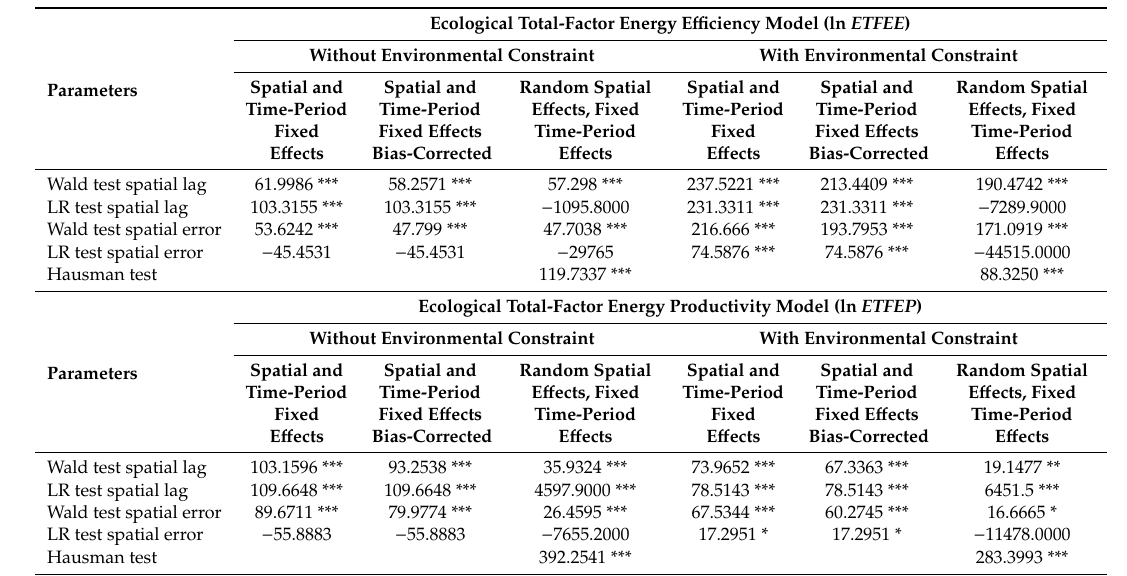
Table 3. Diagnostic tests of spatial